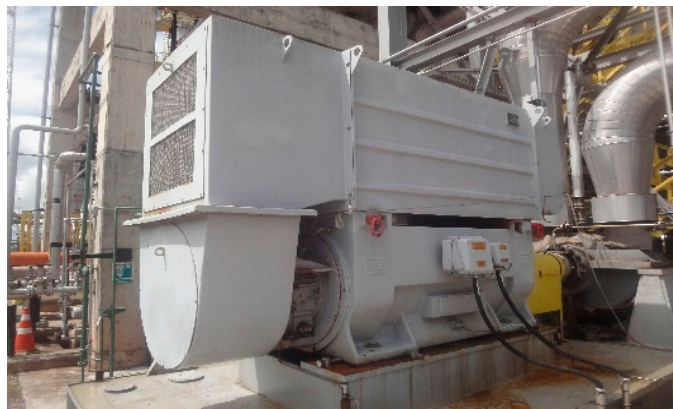
Figure 4. Industrial electric motor driving the principal centrifugal pump.